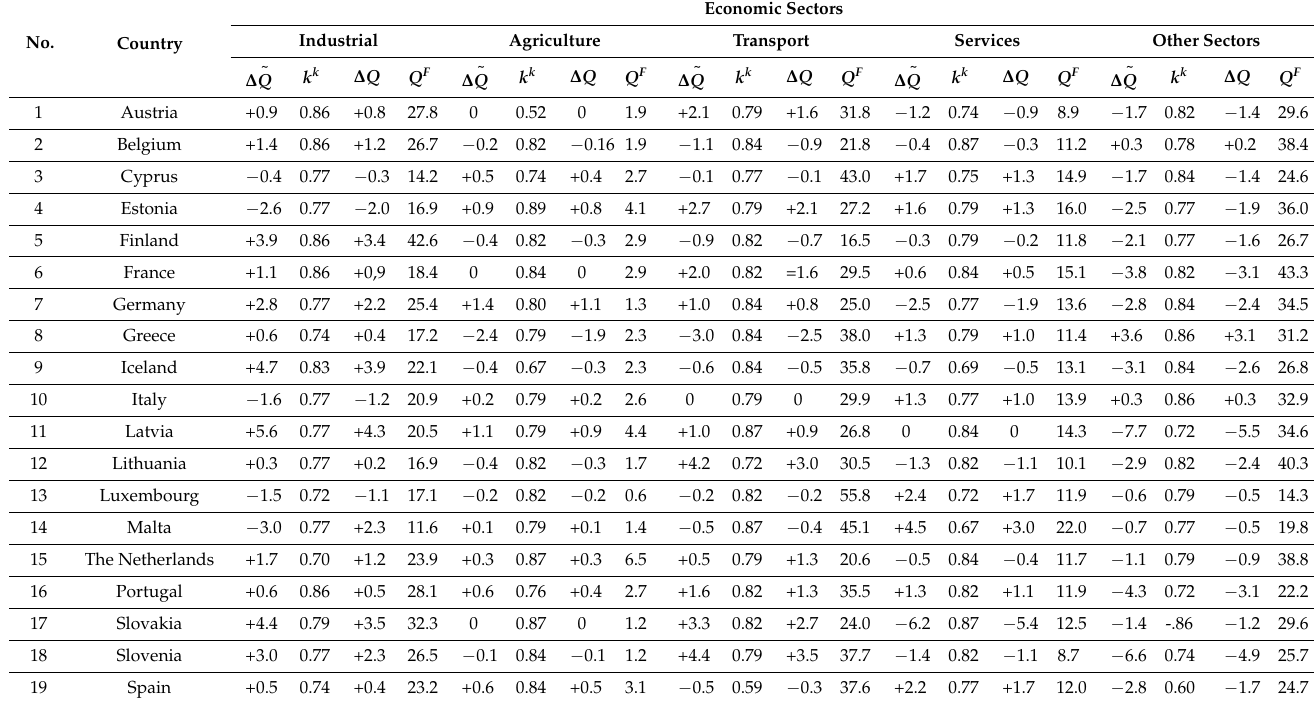
Table 4. Values representing the sectoral energy development in various European countries over the 2009 − 2018 period as a% of the total energy consumption (source: compiled by the authors on the ground,